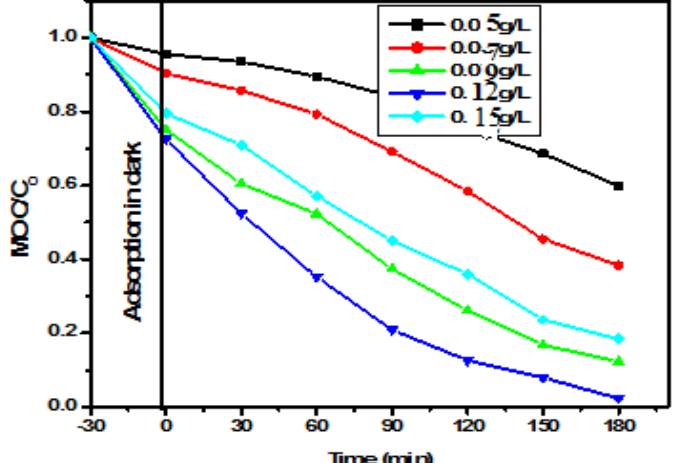
Fig. 8. Effect of catalyst dosage on photodegradation of MO